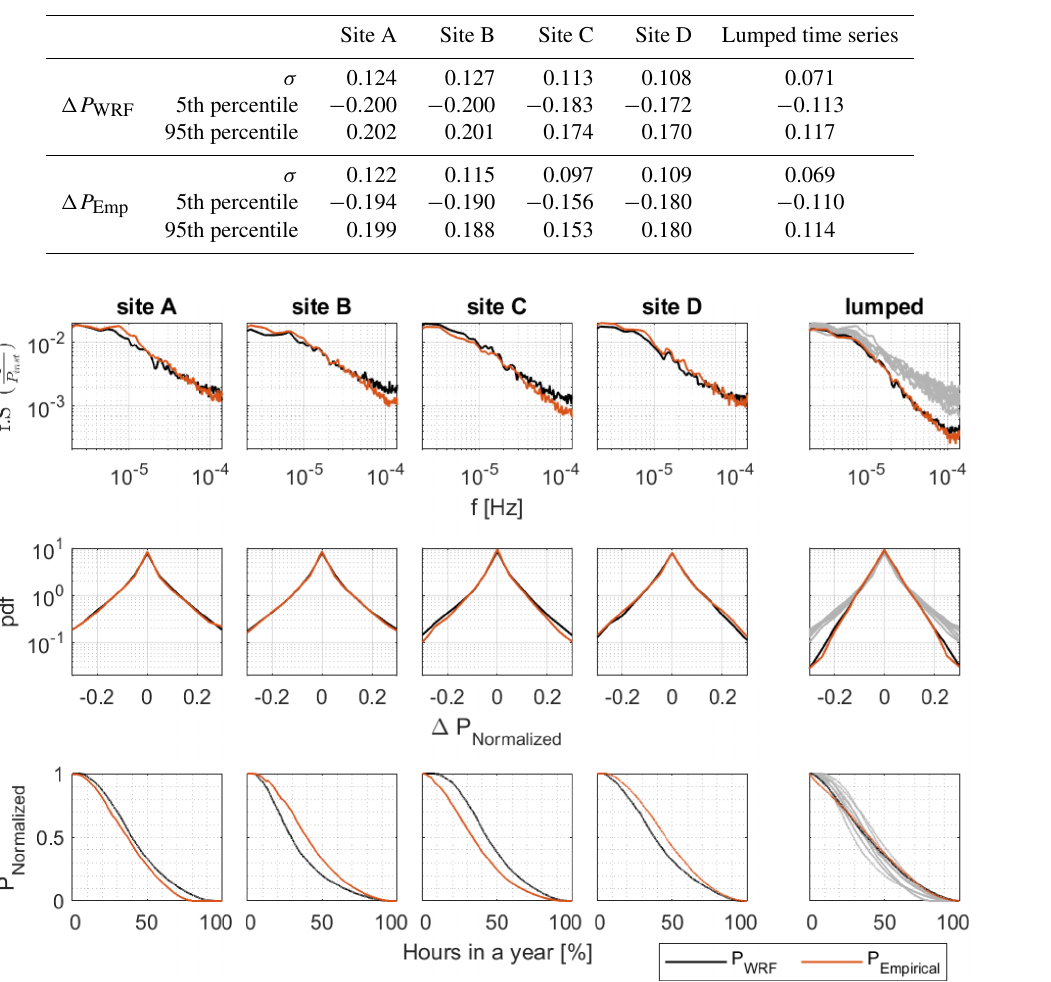
Table 1. Standard deviation ( σ ) and the 5th and 95th percentiles of the hourly step-change function of the power outputs modeled based on WRF-generated wind speeds ( (cid:49)P WRF ) and empirical data ( (cid:49)P Emp ) (see Fig. 2 for site locations). The lumped time series assumes an equal distribution of the wind power capacity over all four locations. All time series are normalized by their rated power.